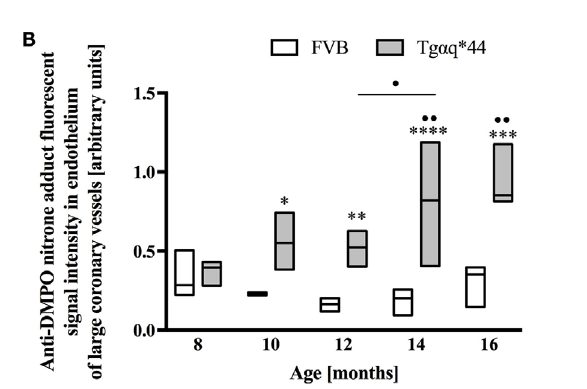
FigUre 4 | Oxidative modifications analyzed using immunohistochemical detection of DMPO nitrone adducts in the endothelium of large coronary vessels. (a) Segmentation steps for representative images of vessels in the left ventricle of 14-month-old mice (image size 250 μ m × 150 μ m); I: initial, triple-strained fluorescent images; II: endothelium segmentation based on lectin-positive staining of the vessel wall; III: DMPO nitrone adduct fluorescent signal specific to the endothelium area. (B) Quantification of the endothelium- specific oxidative modification (see Section “Materials and Methods” for details). Data presented as median ± IQR. Statistical significance was assessed using the two-way ANOVA, with post hoc LSD’s test